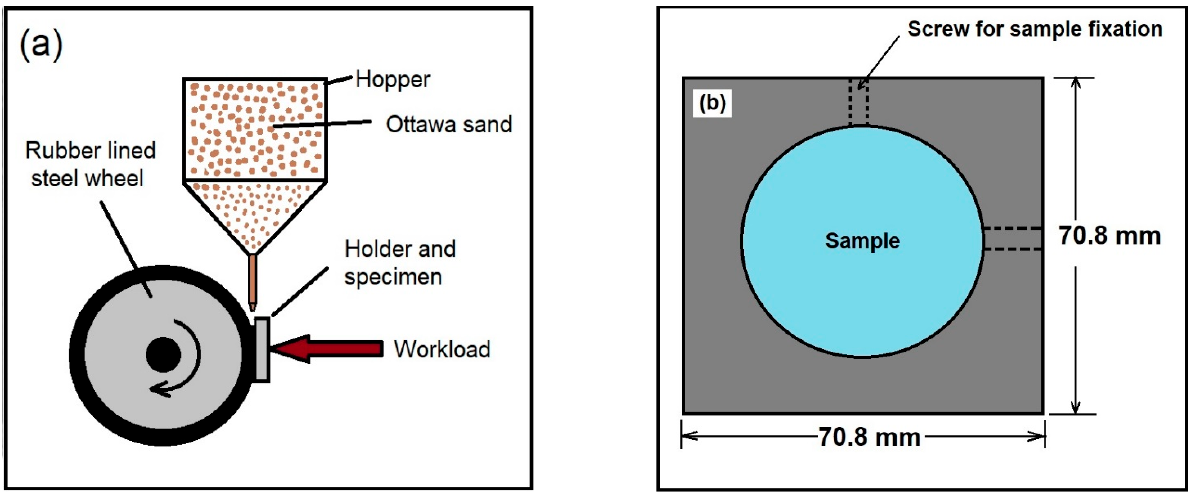
Figure 1. Schematic representation of ( a ) the sand/rubber apparatus for the wear tests and ( b ) the sample’s holder [4].